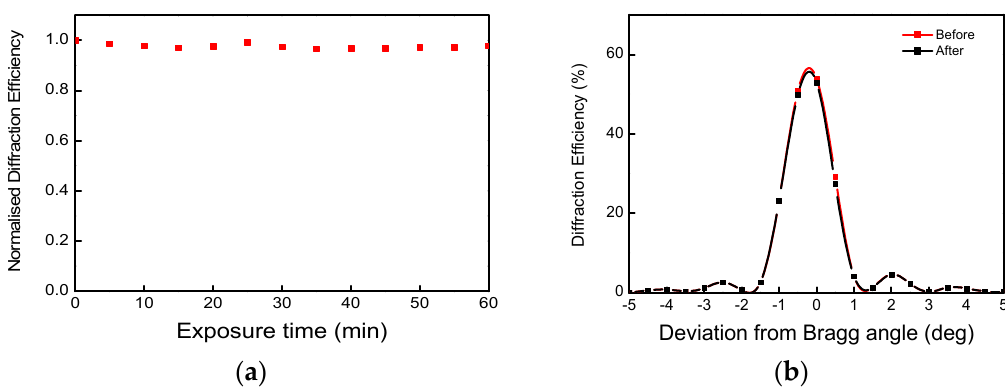
Figure 11. ( a ) Normalized diffraction efficiency of a grating recorded in 70 ± 5 μ m thick layer, spatial frequency of 800 linepairs/mm, recording intensity 5mW/cm2 and total exposure energy 300 mJ/cm 2 ; ( b ) Bragg selectivity curves before (black) and after exposure (red) to water for 60 min.